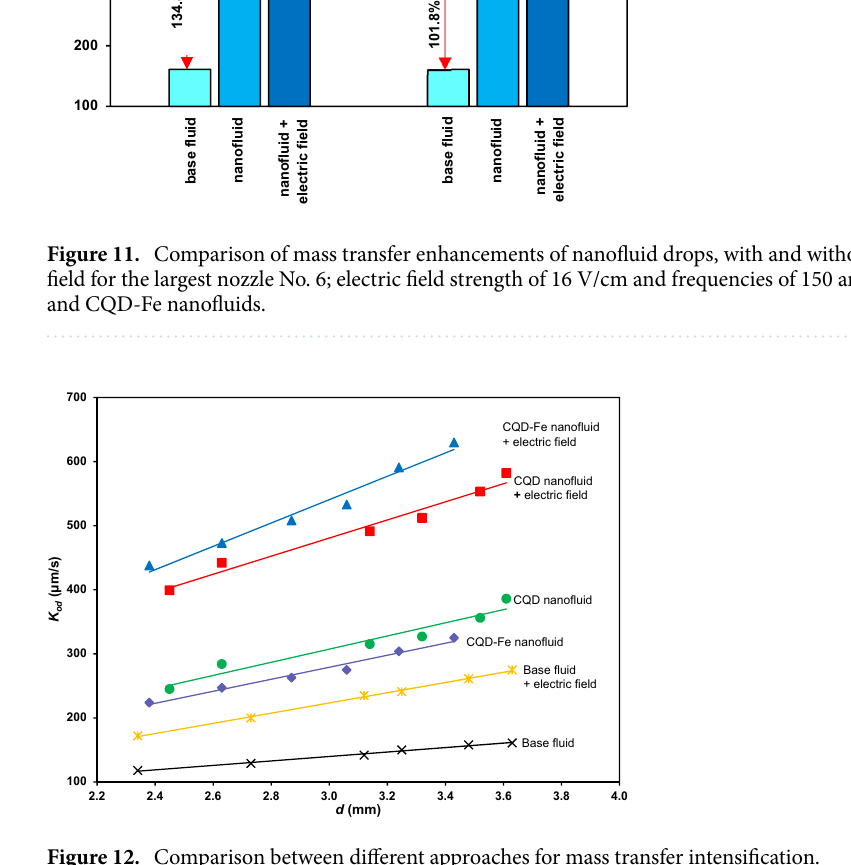
Figure 12. Comparison between different approaches for mass transfer